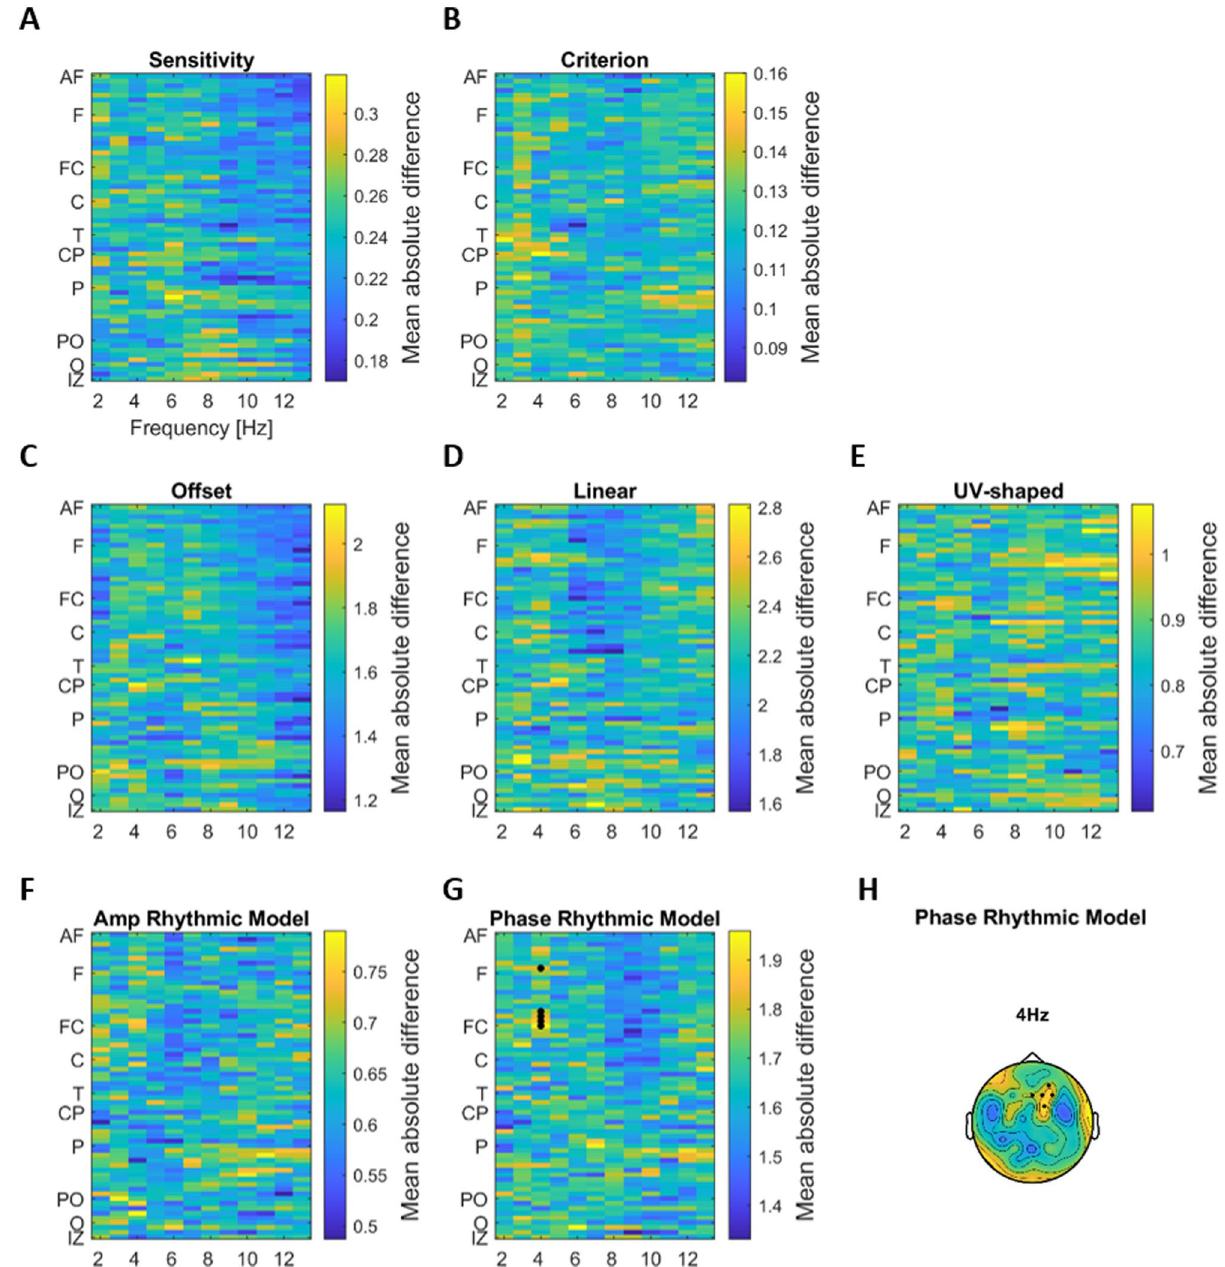
level average of participants-wise differences in regression betas of each component of the perceptual weights between trials with opposing EEG phase, as a function of EEG frequency and EEG electrode. ( H ) Topographic representation of the group-level average of participants-wise differences in the phase of the rhythmic contribution to perceptual weights. Electrodes from significant clusters are marked with black dots (first level significance at p < 0.05, cluster significance at p < 0.01